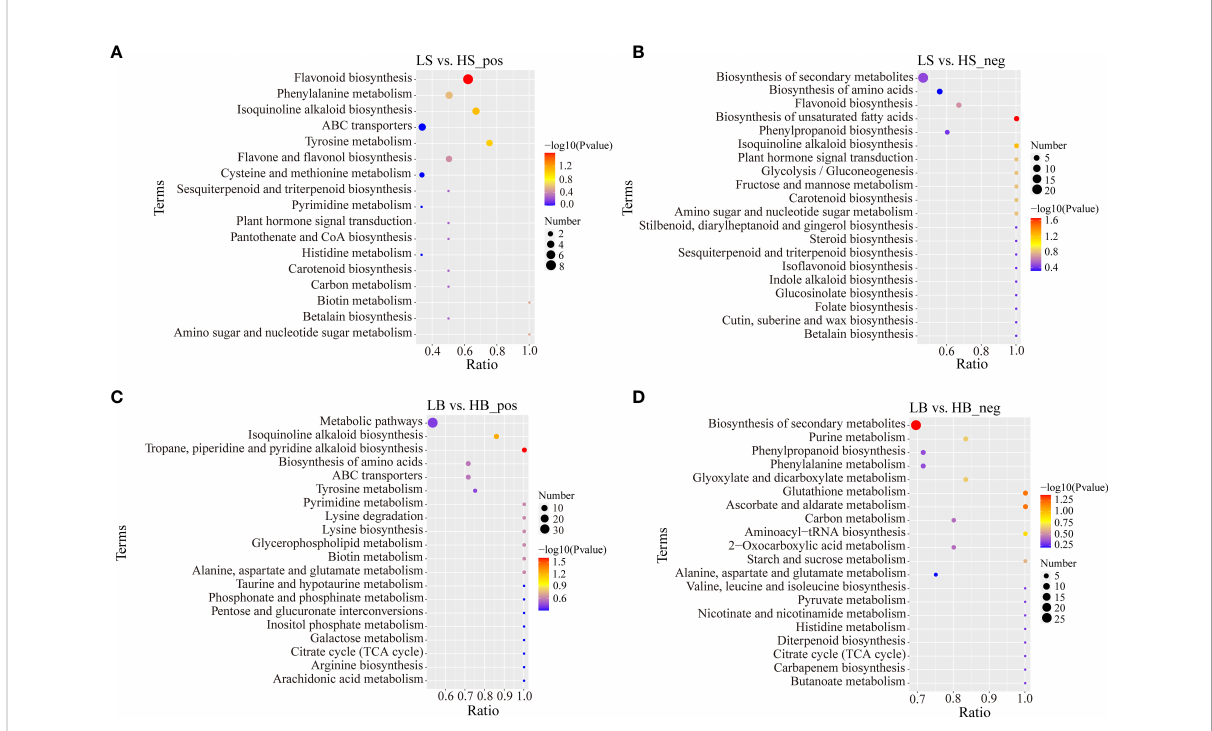
FIGURE 10 KEGG enrichment analysis of DEMs in positive and negative ion mode (only the top 20 results are shown). (A) Bubble plot of KEGG enrichment analysis of H ammodendron DEMs in positive ion mode. (B) Bubble plot of KEGG enrichment analysis of H ammodendron DEMs in negative ion mode. (C) Bubble plot of KEGG enrichment analysis of DEMs in positive ion mode of H persicum . (D) Bubble plot of KEGG enrichment analysis of DEMs in the positive ion mode of H persicum